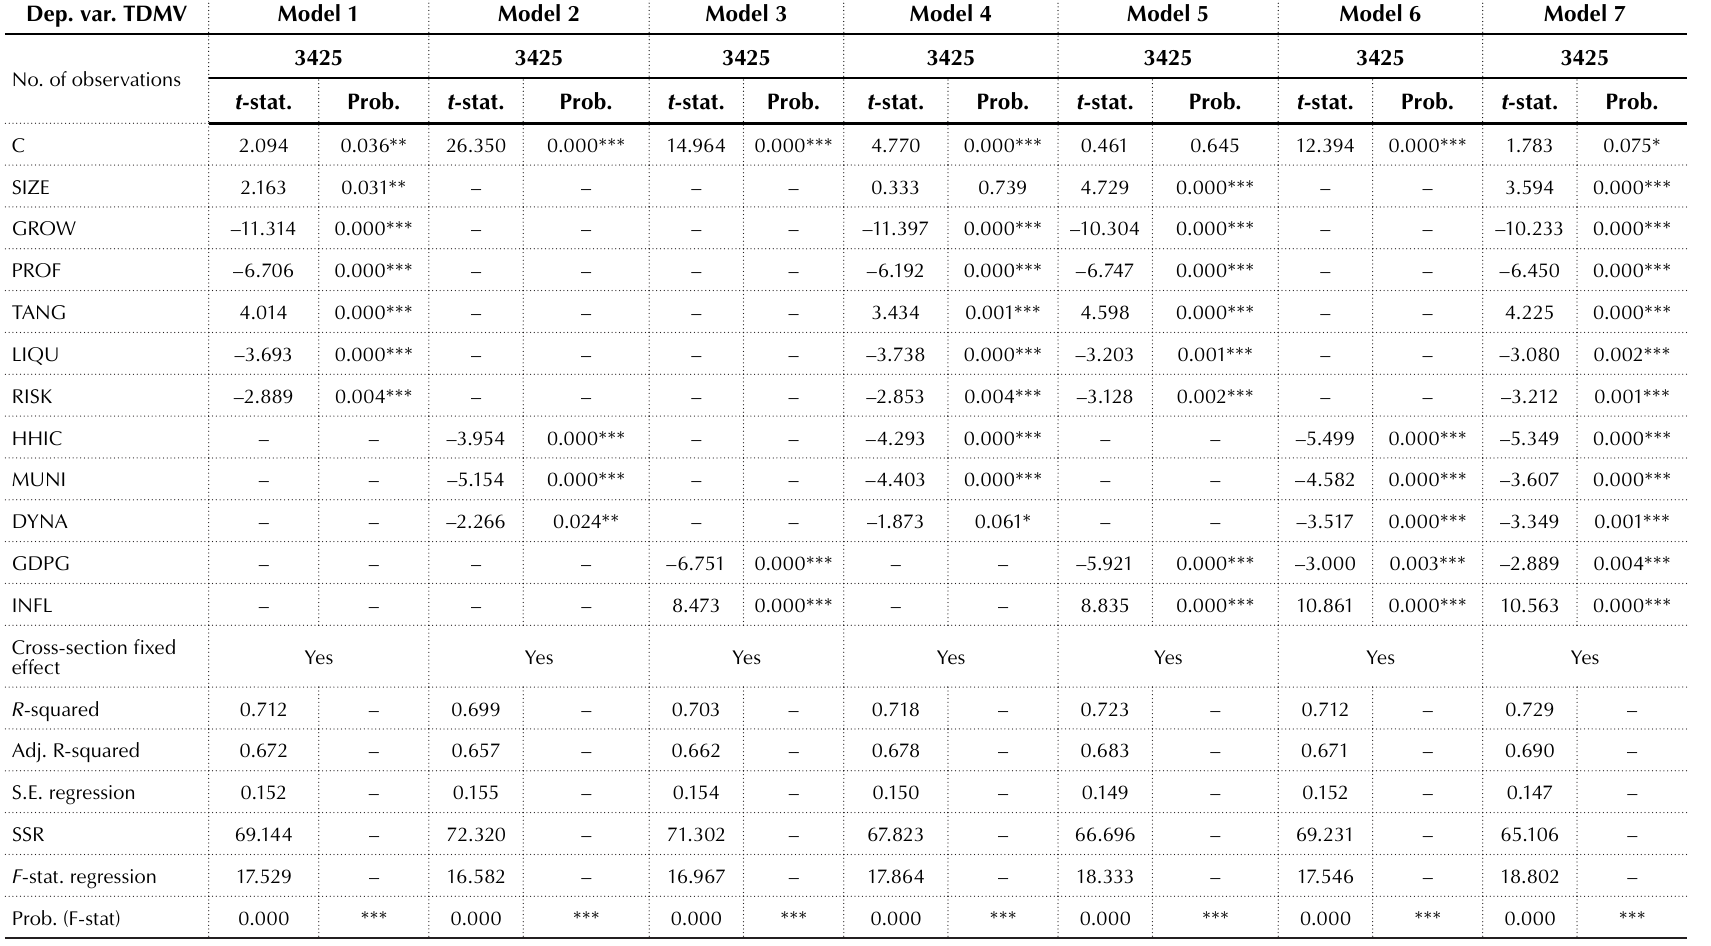
Table 3. Regression results of the relationship models between debt ratio and its determinants – full sample data Dep. var.